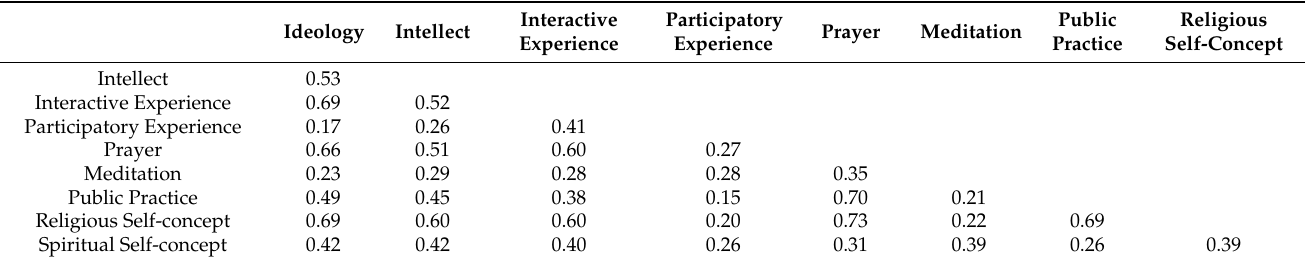
Table A2. Correlations of the nine indicators of religiosity and